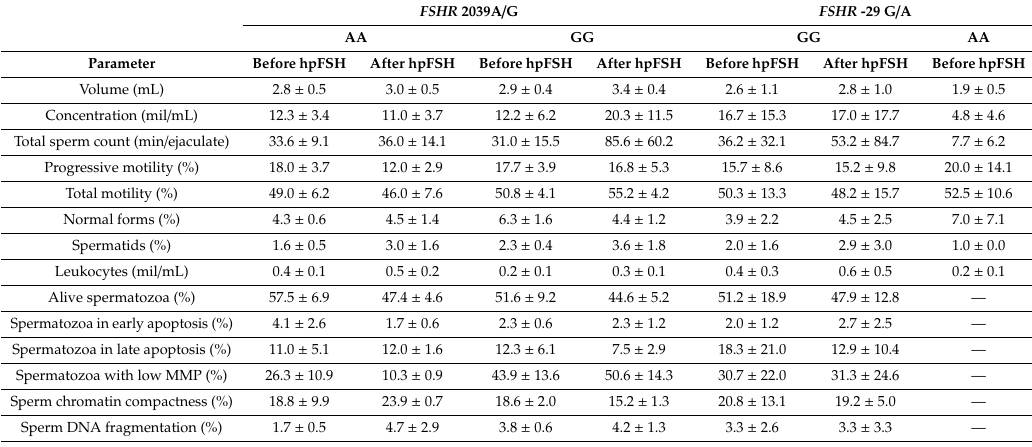
SpermatozoawithlowMMP(%) —